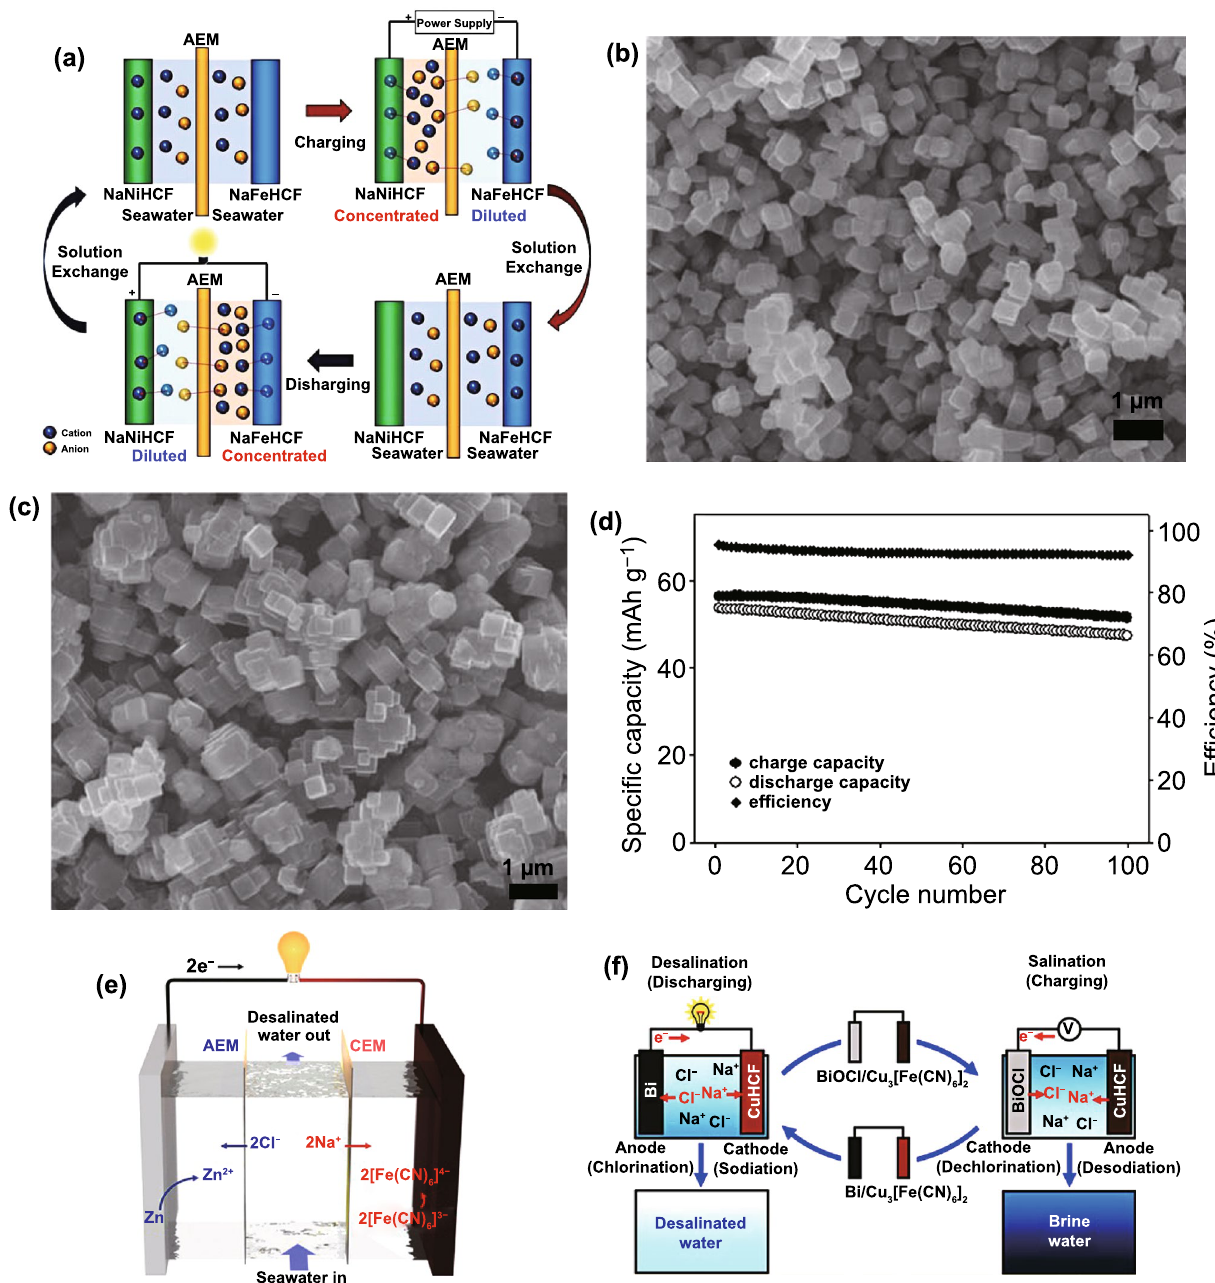
Fig. 14 a Principle of Na 2 Ni[Fe(CN) 6 ]/Na 2 Fe[Fe(CN) 6 ] rocking-chair desalination battery. b SEM image of Na 2 Ni[Fe(CN) 6 ] particles. c SEM image of Na 2 Fe[Fe(CN) 6 ] particles. d Galvanostatic cycling performance of the Na 2 Ni[Fe(CN) 6 ]/Na 2 Fe[Fe(CN) 6 ] cell in seawater. Reproduced with permission from Ref. [144]. Copyright 2017, American Chemical Society. e Schematic of zinc/ferricyanide hybrid desalination flow bat- tery operation during discharge (desalination) and charge (salination). Reproduced with permission from Ref. [145]. Copyright 2018, American Chemical Society. f Scheme showing the operation of the Cu 3 [Fe(CN) 6 ] 2 ·nH 2 O/Bi desalination battery. Reproduced with permission from